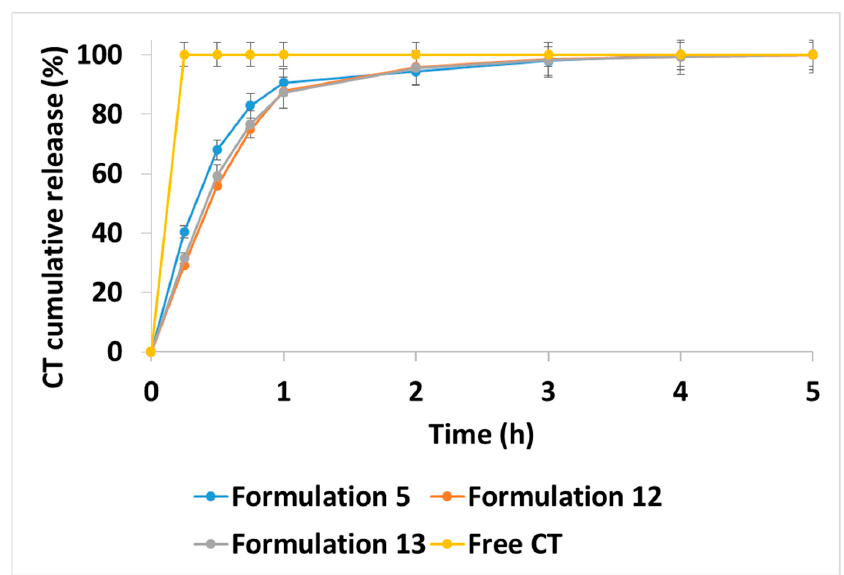
Figure 3. Colistin (CT) release kinetics from different CT-HA-DEAECS PECs formulations at 37 °C into phosphate-buffered saline (PBS). Free CT corresponds to an equivalent concentration of the CT in the PEC. Error bars indicate standard deviations (n = 3).